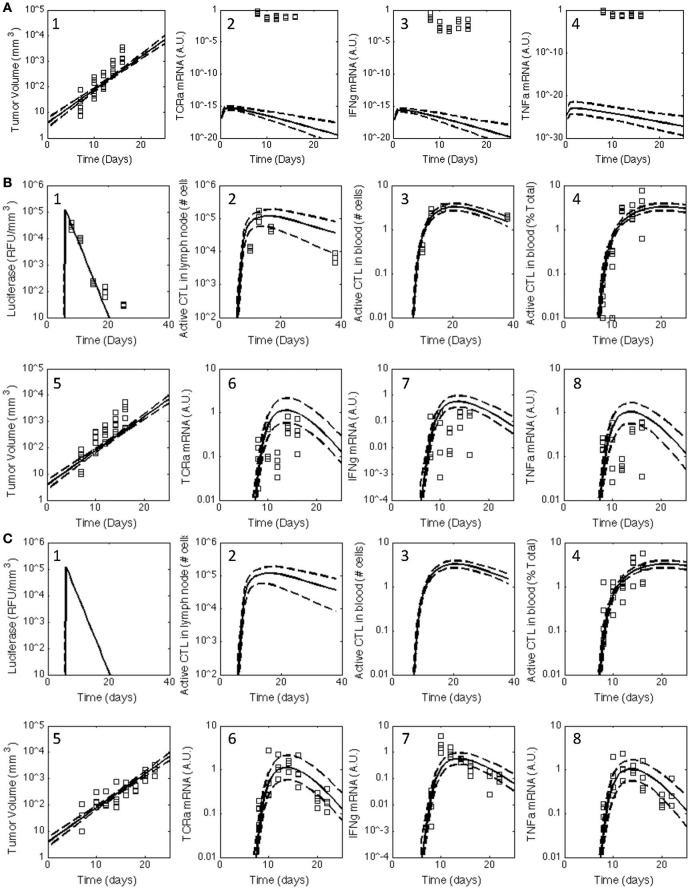
Posterior distribution in the model predictions obtained for the V1 model compared against the observed data for all three treatment groups. The experimental data (squares) acquired for untreated C57Bl/6 mice (A) and mice immunized with rHuAd5-hgp100 (B) and rHuAd5-hDCT (C) adenovirus expression vector on day 5 following subcutaneous implantation of 1 × 106 B16F10 tumor cells were compared to the posterior distributions in the model predictions obtained using the V1 model. The comparisons between experimental measures of the anti-tumor immune response and corresponding simulated values are shown separately in subpanels. Experimental observations include antigen expression (luciferase expression: B-1,C-1), activated CD8+ T cells in lymph node (B-2,C-2), activated CD8+ T cells in blood (percent of total CD8+ T cells: B-3,B-4,C-3,C-4), tumor volume (A-1,B-5,C-5), TCRa mRNA expression in tumor (A-2,B-6,C-6), IFNG mRNA expression in tumor (A-3,B-7,C-7), and TNFα mRNA expression in tumor (A-4,B-8,C-8). Using an empirical Bayesian approach, the uncertainty in the model predictions are represented by a solid line, which represents the median response, and dashed lines that enclose the 95% credible interval. Luciferase, active CD8+ T cells in lymph node, and activated CD8+ T cells in blood are not shown for untreated C57Bl/6 mice as they are essentially zero.